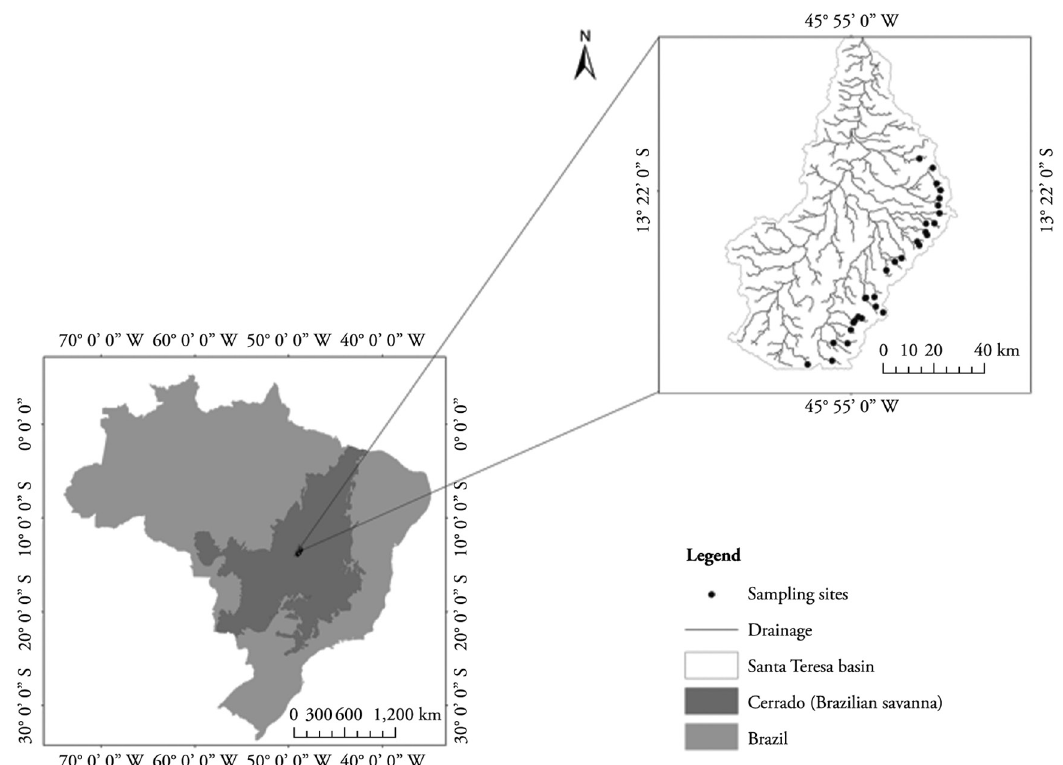
Figure 1. Location of the study area in